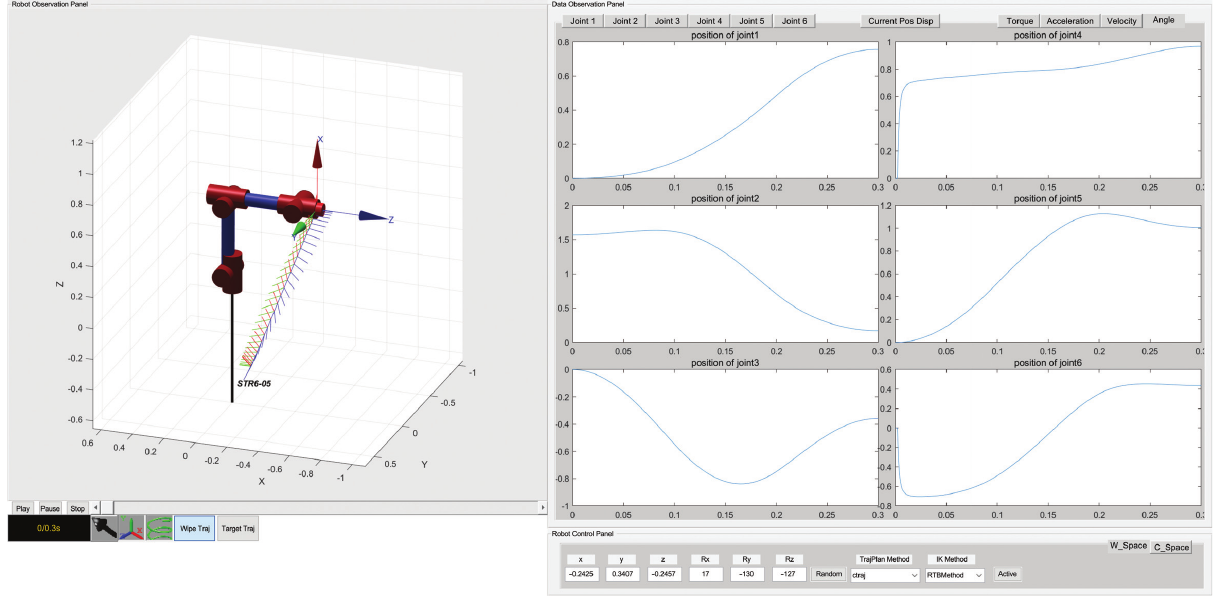
Figure 5: Simulation tool based on